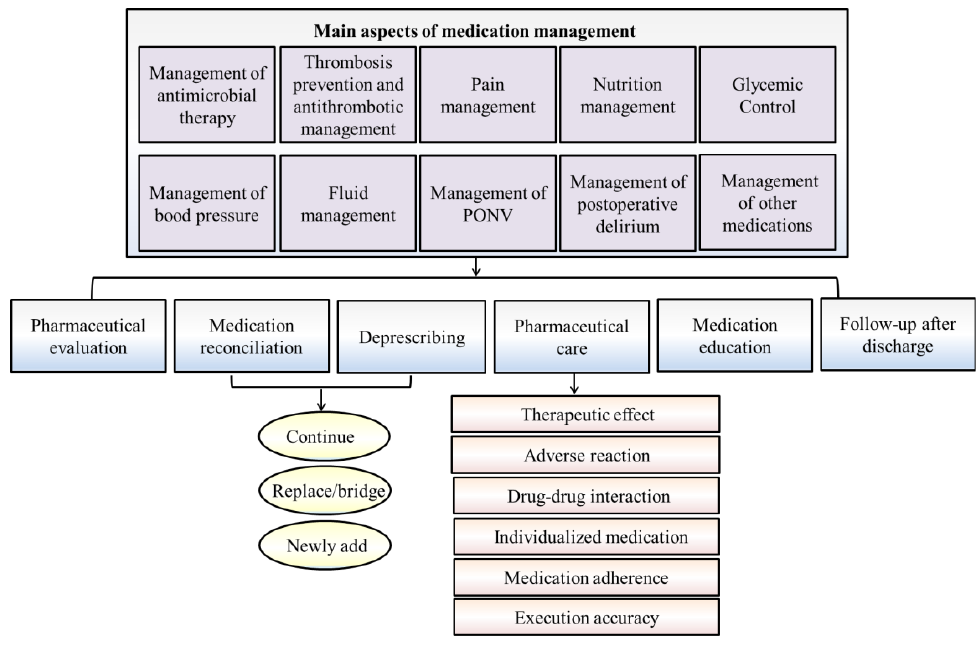
Figure 1. The main aspects of perioperative medication management and surgical pharmacists’ intervention within ERAS programs [17]. PONV: postoperative nausea and vomiting. Table 1. Representative drugs commonly used during the perioperative period and key points of medication monitoring.